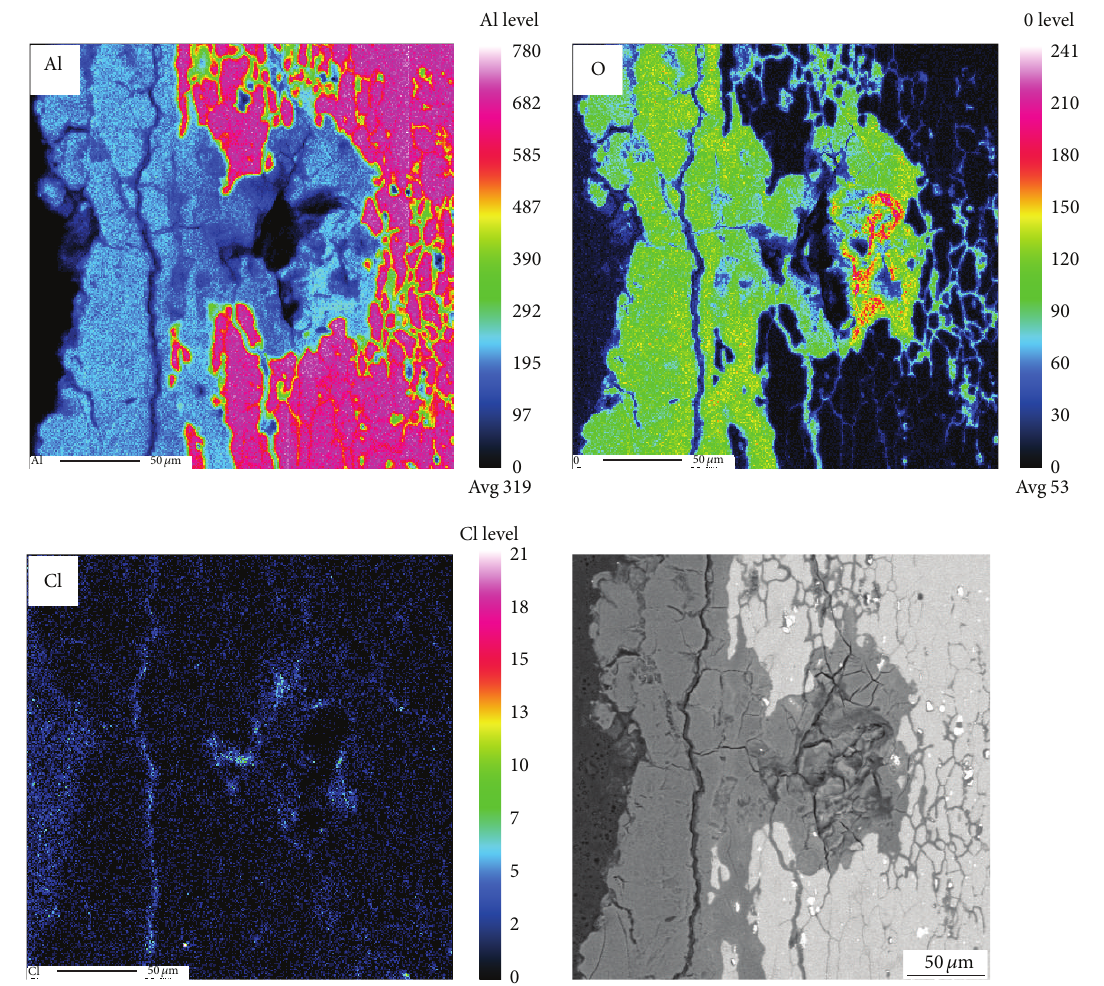
Figure 9: EPMA mapping of the main elements distributing on the cross section of the specimen after exposure for 48 months.